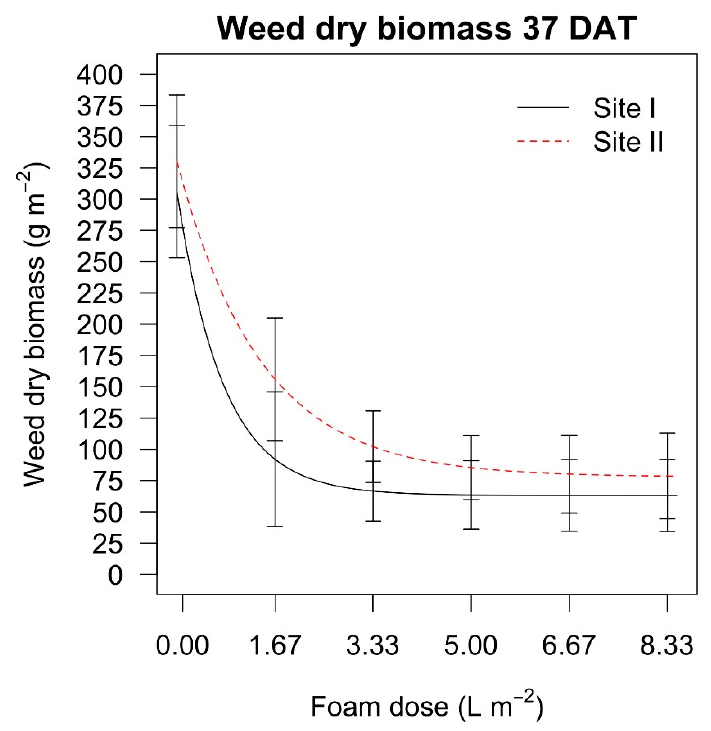
Figure 7. Exponential decay curves with 95% confidence interval bars of weed dry biomass collected 37 days after the treatment (37 DAT) as a ff ected by the foam dose (0, 1.67, 3.33, 5.00, 6.67 and 8.33 L m − 2 , respectively) and the site in the Festuca arundinacea (Schreb.) infested field experiment. The parameters and standard errors of the non-linear regression curves (Equation (2)) are: c = 63.13 ( ± 14.09) and 77.89 ( ± 17.79) for Site I and II, respectively; d = 305.98 ( ± 25.88) and 330.24 ( ± 25.94) for Site I and II, respectively; e = 0.80 ( ± 0.33) and 1.42 ( ± 0.50) for Site I and II, respectively. Table 7. Mean values and standard errors (SE) estimated from the exponential decay model (Equation (3)) of the weed dry biomass as affected by the different foam doses (0, 1.67, 3.33, 5.00, 6.67 and 8.33 L m − 2 , respectively) and the site at 37 days after the treatment in the Festuca arundinacea (Schreb.) infested field experiment. The non-linear regression curves are plotted in Figure 7. Mean Values (±SE) Site I